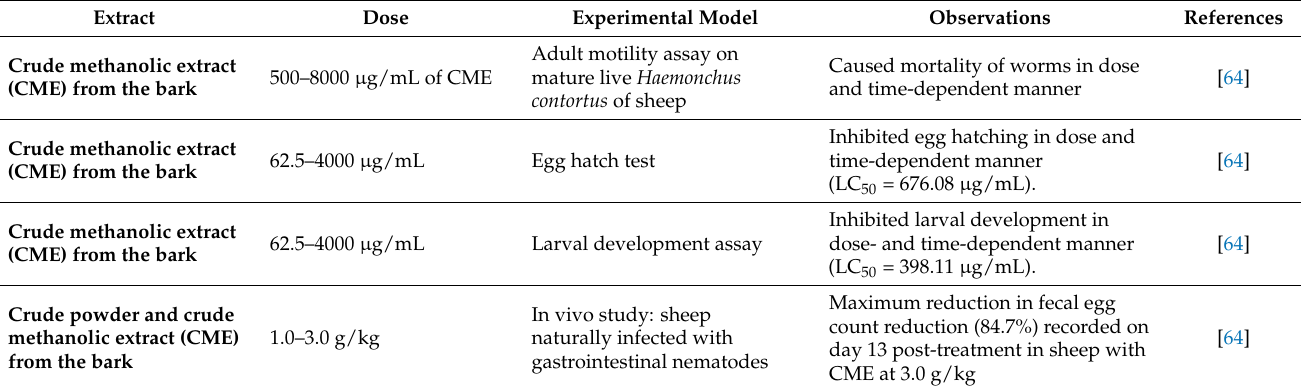
Table 4. The anthelmintic effects of Ziziphus nummularia